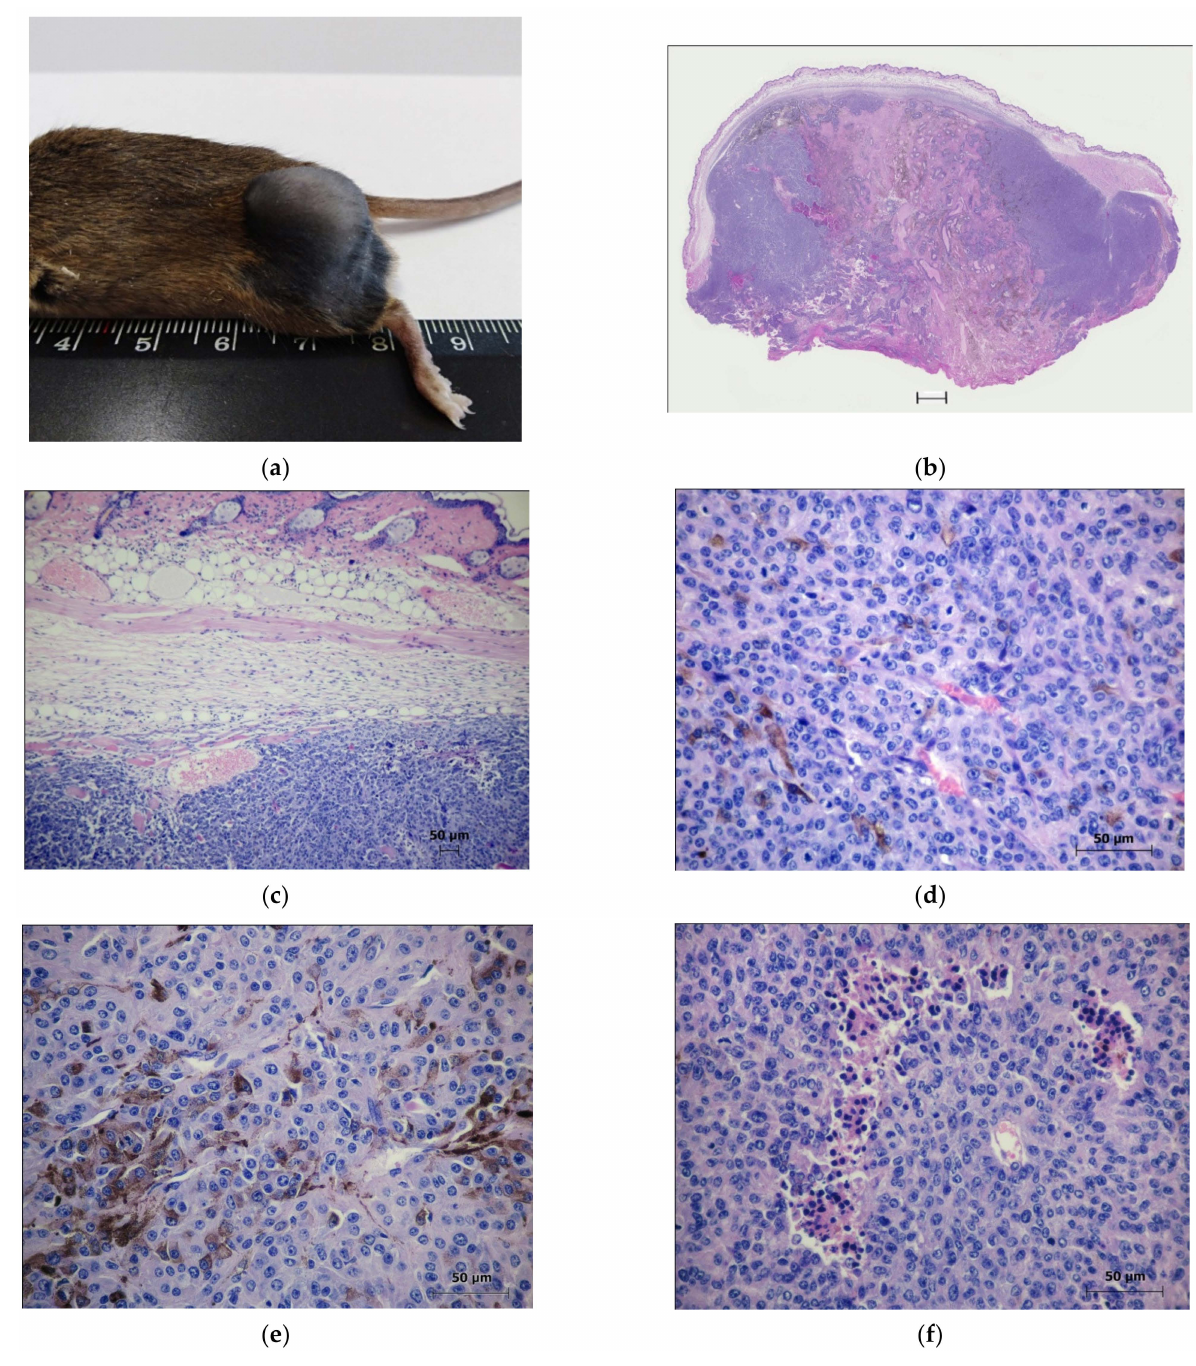
Figure 6. The morphology pattern of the murine B16 melanoma in the control groups (control 3 and control 4) on the 30th day after transplantation: ( a ) Macrophoto of the murine B16 melanoma on the 30th day after implantation under the skin of the thigh; ( b ) The morphological picture of the tumor on the 30th day after the implantation. Staining with hematoxylin and eosin. Scan; ( c ) A peritumoral zone of the melanoma 30 days after the implantation. Staining with hematoxylin and eosin. × 10; ( d ) A histostructure of the B16 melanoma in a zone of the solid growth. Staining with hematoxylin and eosin. × 40; ( e ) The melanocytes in the tumor parenchyma in the hypoxic zone. Staining with hematoxylin and eosin. × 40; ( f ) The micronecrosis in the parenchyma of the B16 melanoma. Staining with hematoxylin and eosin. ×